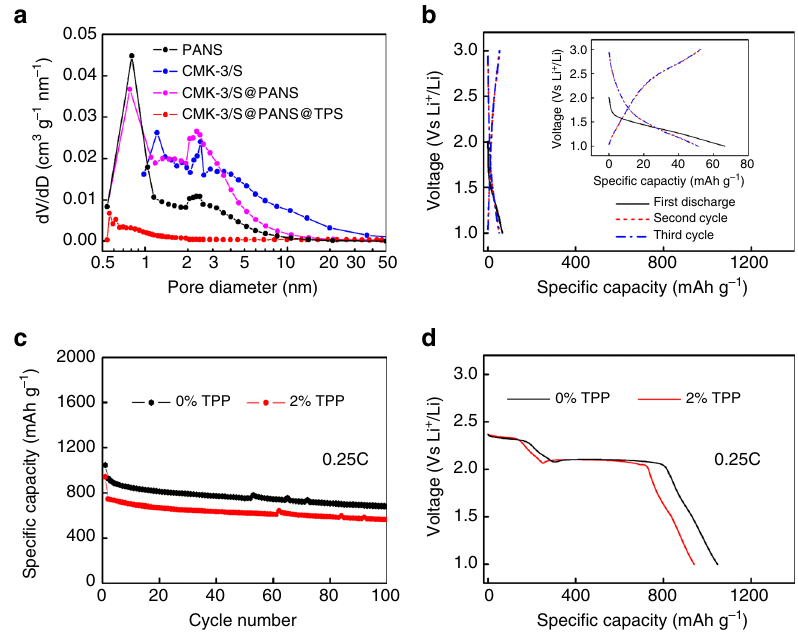
Fig. 4 Pore size distribution and electrochemical performance of the controlled samples. a The pore size distribution of PANS, CMK-3/S, CMK-3/S@PANS, and CMK-3/S@PANS@TPS materials. b Galvanostatic discharge/charge curves of the control cell with the TPS layer wrapped on CMK-3/S@PANS before cell assembly. The inset fi gure shows the enlarged discharge/charge curves. c Cycling performance of the CMK-3/S cells with and without TPP in the electrolyte. d The initial discharge curves of the CMK-3/S cells with and without TPP in the